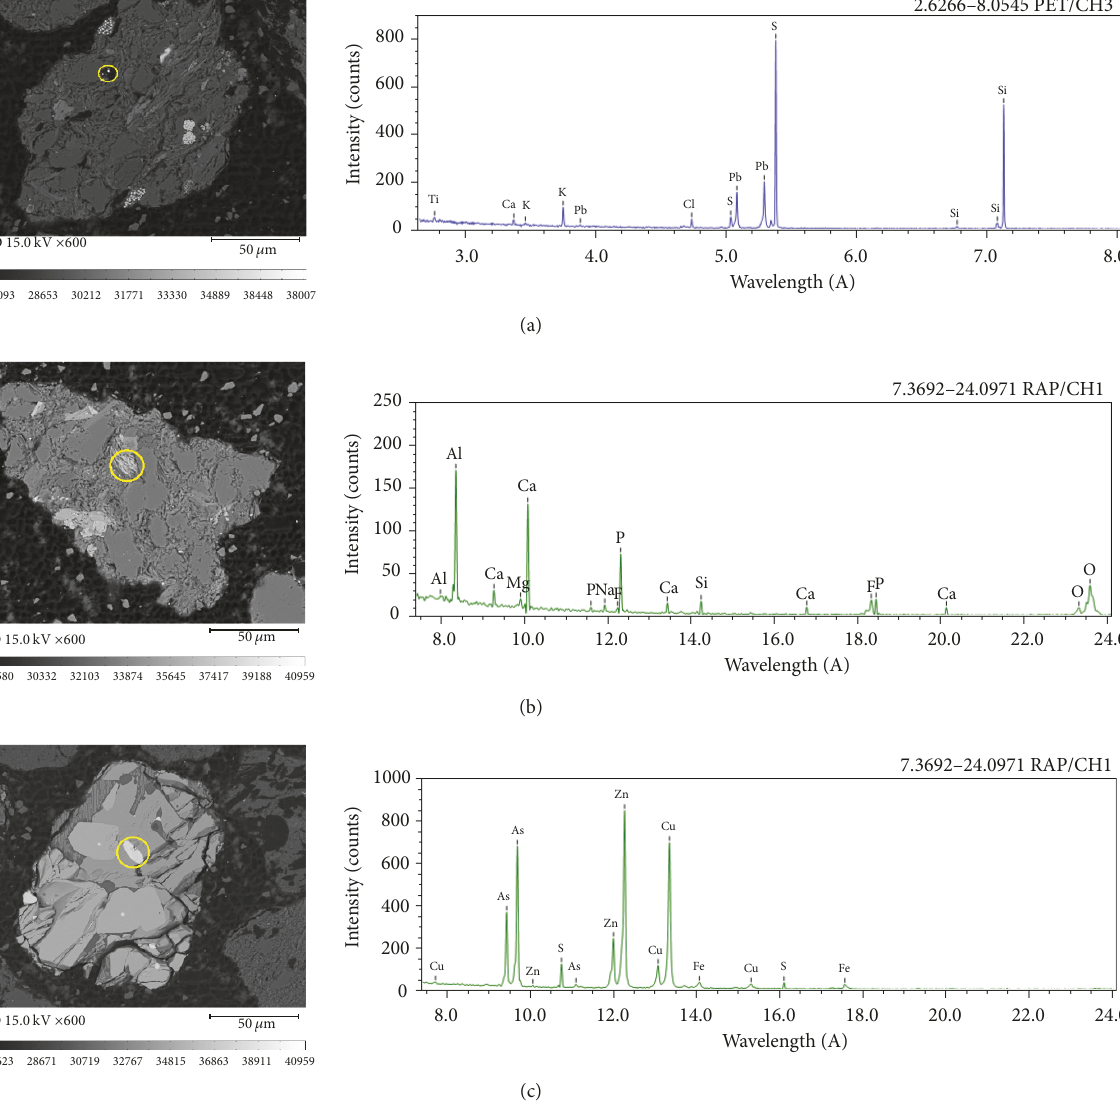
Figure 8: Qualitative analysis of particles containing harmful elements: (a) lead particle; (b) fluoride particle; (c) arsenic